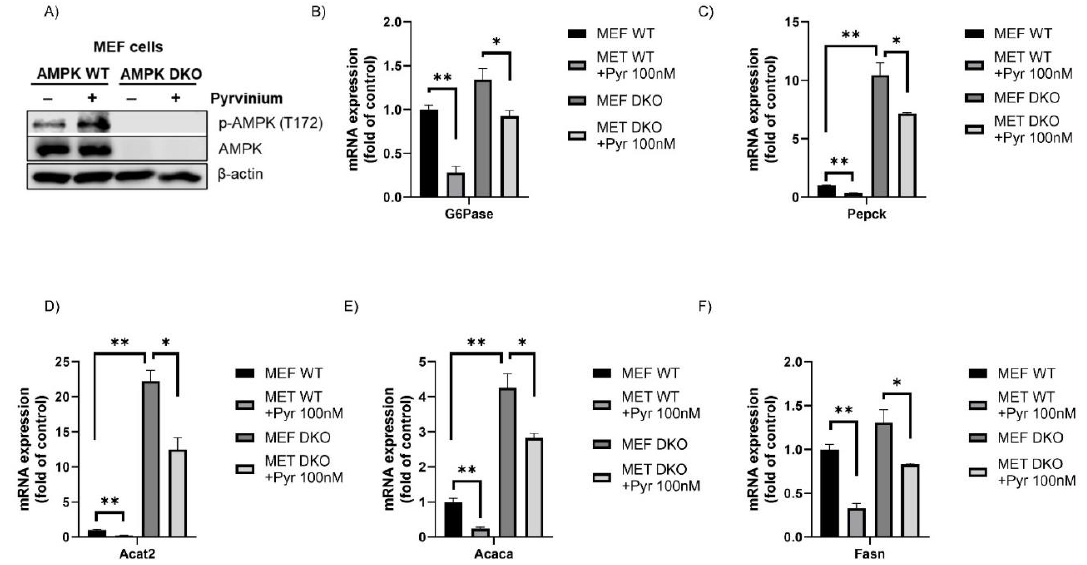
Figure 5. Effect of AMPK deletion on gluconeogenic and lipogenic gene expression in mouse embryonic fibroblasts (MEF) cells. ( A ) Protein expression of phosphorylated and total AMPK in AMPK α 1/ α 2 wild-type (WT) and double knockout (DKO) MEF cells. ( B – F ) Relative mRNA expression of gluconeogenic genes G6Pase ( B ), Pepck ( C ) and lipogenic genes Acat2 ( D ), Acaca ( E ), Fasn ( F ) in AMPK α 1/ α 2 WT and DKO MEF cells treated without and with 100nM pyrvinium for 24 h. Control: WT MEF cells without pyrvinium treatment. * p < 0.05; ** p < 0.01. Data are representative of at least three independent